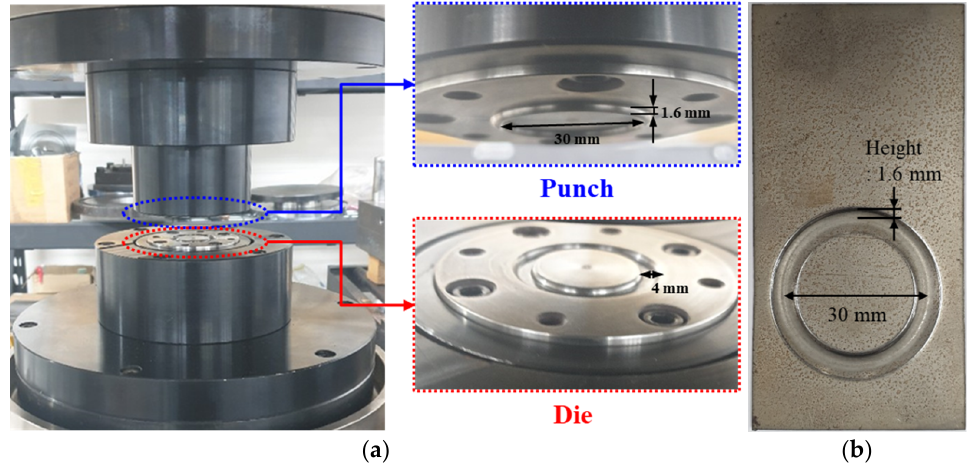
Figure 10. Preform die set: ( a ) punch and die set; ( b ) preformed target sheet.